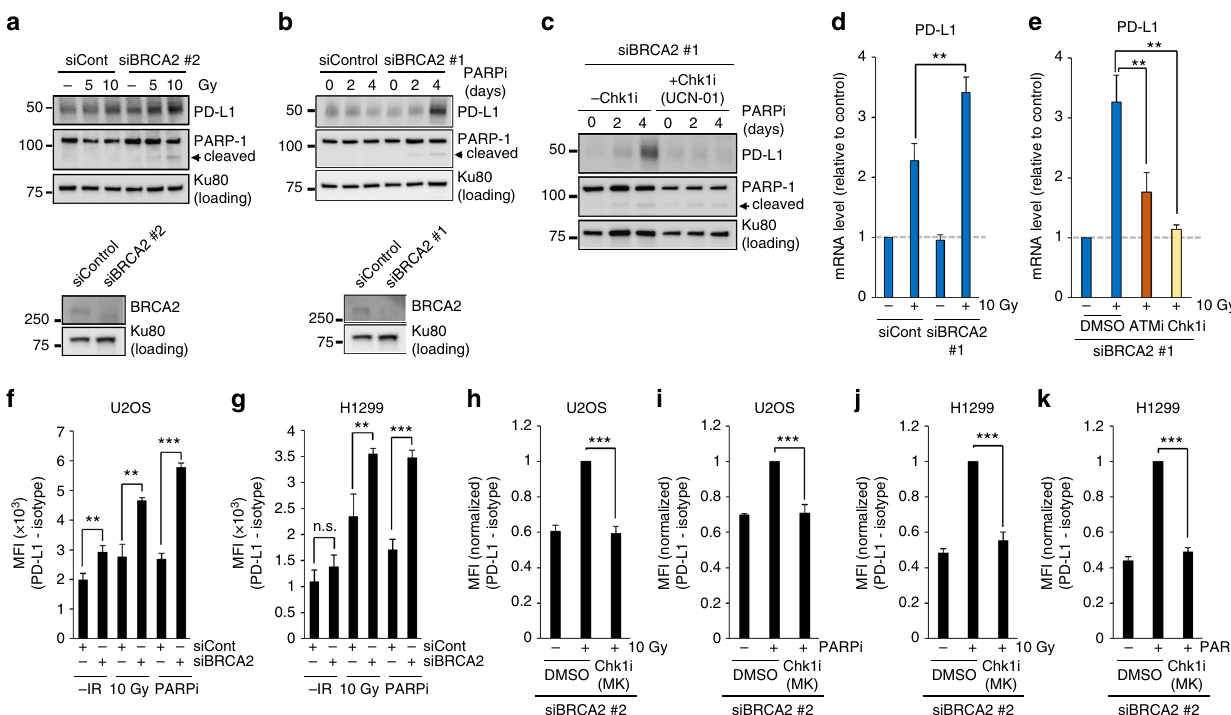
Fig. 4 Depletion of BRCA2 enhances PD-L1 upregulation after DSBs. a Depletion of BRCA2 enhances the upregulation of PD-L1 after IR. U2OS cells were exposed to BRCA2 siRNA. PD-L1 was examined 48 h after 5 or 10 Gy. Knockdown ef fi ciency of BRCA2 is shown in the bottom panel. b PARP